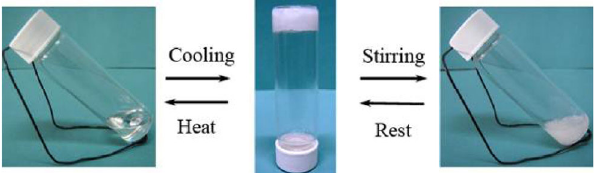
Fig. 5 A gel lubricant that reversibly changes its physical states. Reproduced with permission from Ref. [25]. Copyright Royal Society of Chemistry,